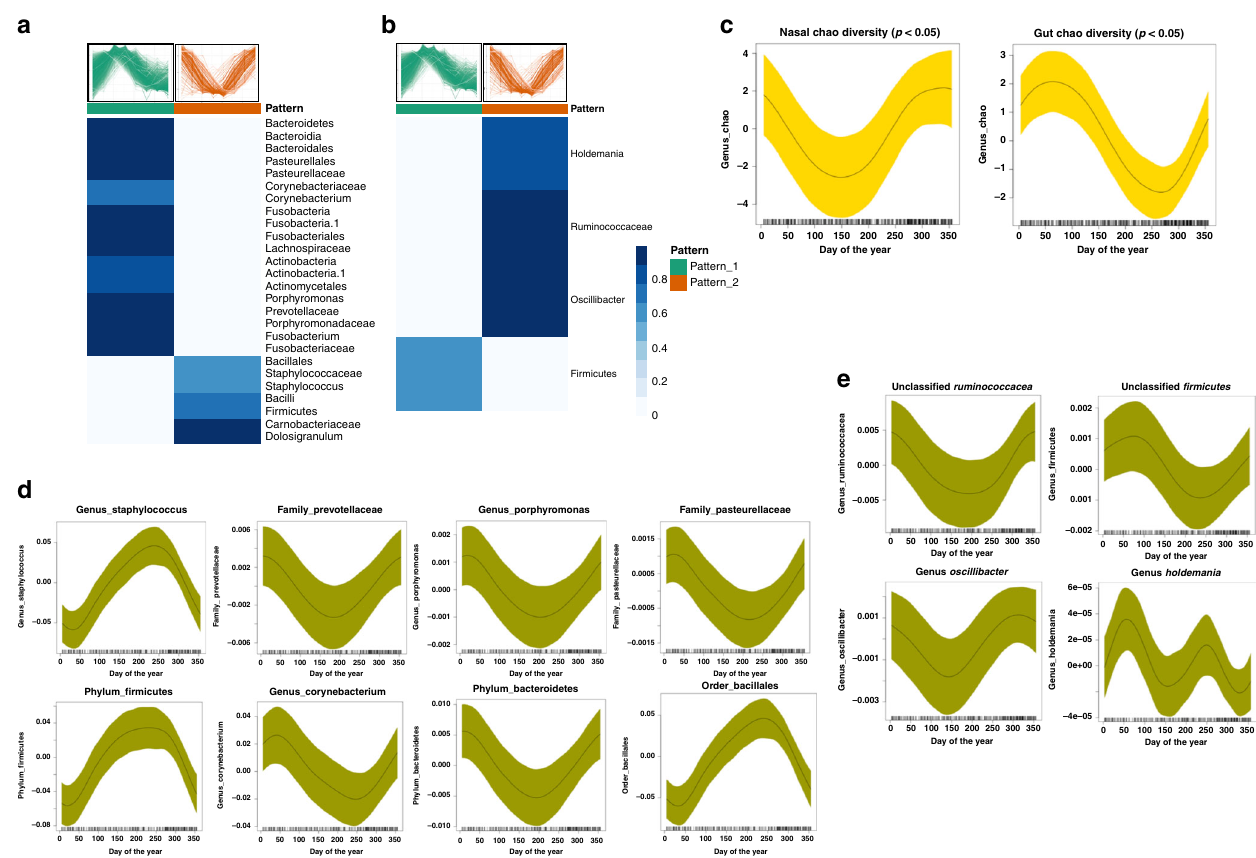
Fig. 4 Nasal and gut microbial taxa correlate with omics seasonal patterns. Correlation of ( a ) nasal and ( b ) gut microbial taxa with the two omics seasonal patterns. The heatmap shows cluster membership values (which are on a scale of 0 and 1) based on existing cluster centroids (omics pattern one is shown in green color and omics pattern two is shown in orange color). c Gut and nasal microbiome diversity scores (by Chao diversity) over the year. The Y -axis shows the days of the year and X -axis shows normalized Chao diversity scores. The shaded area represents 95% con fi dence bounds computed as ±1.96 standard deviation of model coef fi cients. Standard deviations were derived from a maximum likelihood fi t. d Gut microbial taxa and ( e ) nasal microbial taxa with seasonal